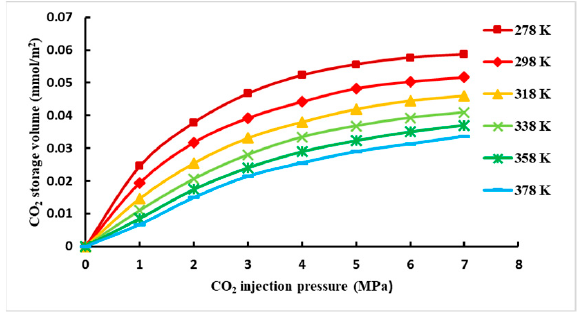
Figure 11. Relation curve between CO 2 storage capacity and injection pressure.